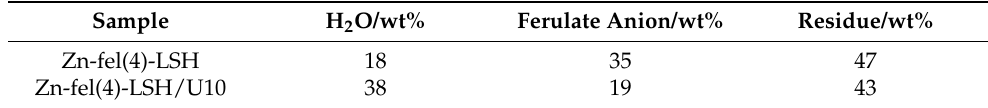
Table 3. Mass percentage (wt%) attributed to water loss, ferulate decomposition, and residue formed by thermal decomposition of the Zn-fel(4)-LSH and Zn-fel(4)-LSH/U10 samples.